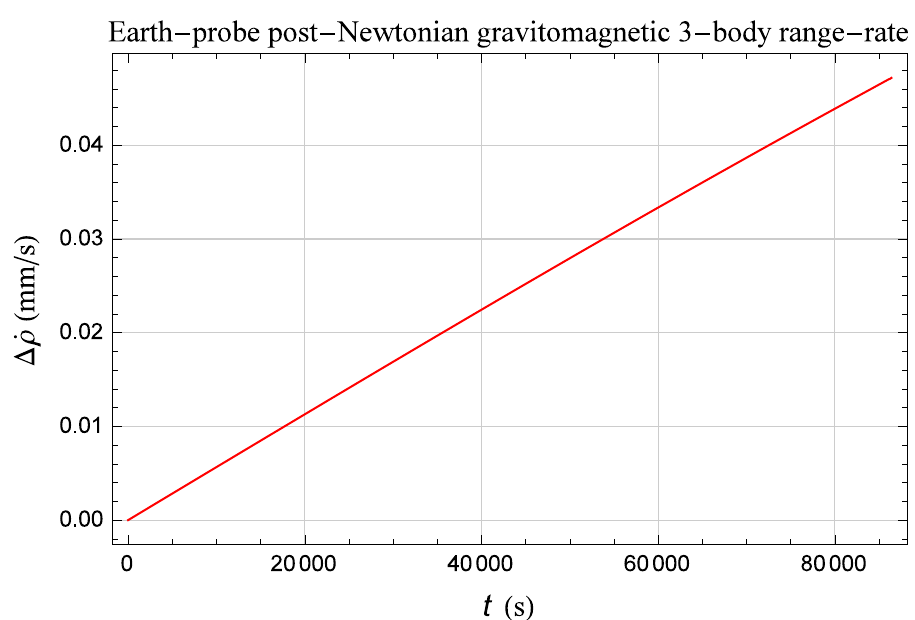
Figure 2. Numerically produced Earth-probe range-rate shift ∆ ˙ ρ ( t ) due to the pN gravitomagnetic 3-body acceleration of Equation (18). We numerically integrated the solar system barycentric equations of motion in Cartesian rectangular coordinates of the Earth, Jupiter, its Galilean moons and a fictitious test particle orbiting Europa over 1 d. In both runs, sharing the same initial conditions for all the existing natural bodies retrieved from the database JPL HORIZONS (https://ssd.jpl.nasa.gov/?horizons) at the arbitrary epoch of midnight of 1 January 2030, we modeled the mutual attractions among all the planets and the satellites involved to the Newtonian level, with the exception of Equation (18) which was added to the other classical gravitational pulls felt by the orbiter in one of the runs. Then, we numerically calculated two range-rate time series, and subtracted the purely Newtonian one from that including also Equation (18). The orbital configuration adopted for the spacecraft, referred to Europa, was a 0 = 3.55 R , e 0 = 0.69, I 0 = 100 deg, Ω 0 = 90 deg, ω 0 = 40 deg, f 0 = 50 deg, where R is the radius of Jovian